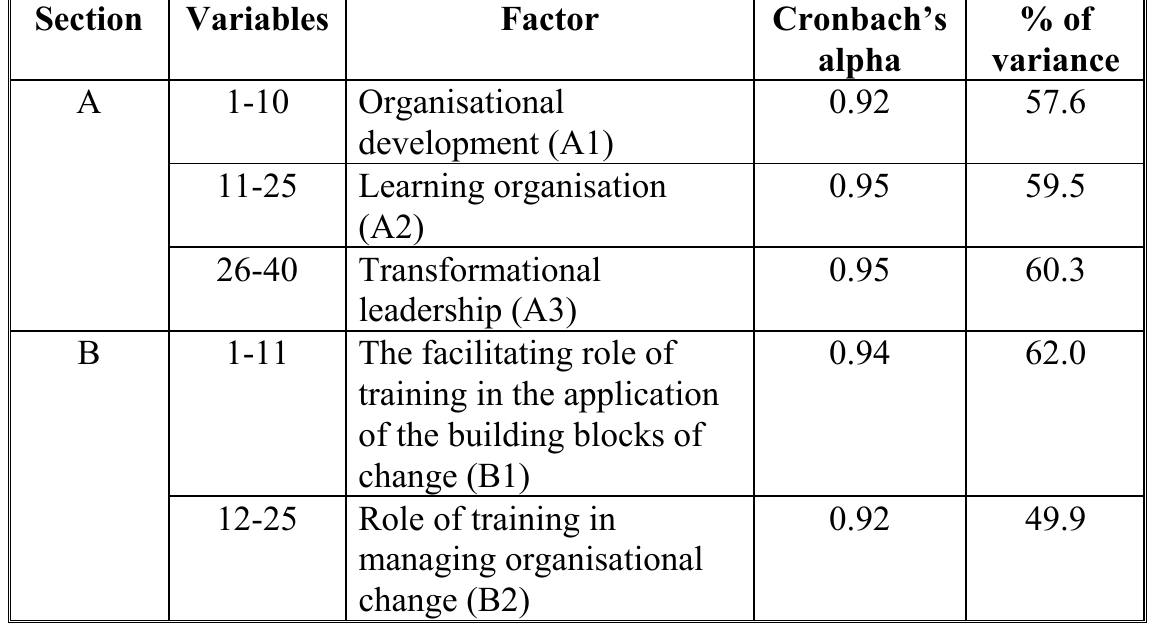
4 highlights the internal reliability of the measuring